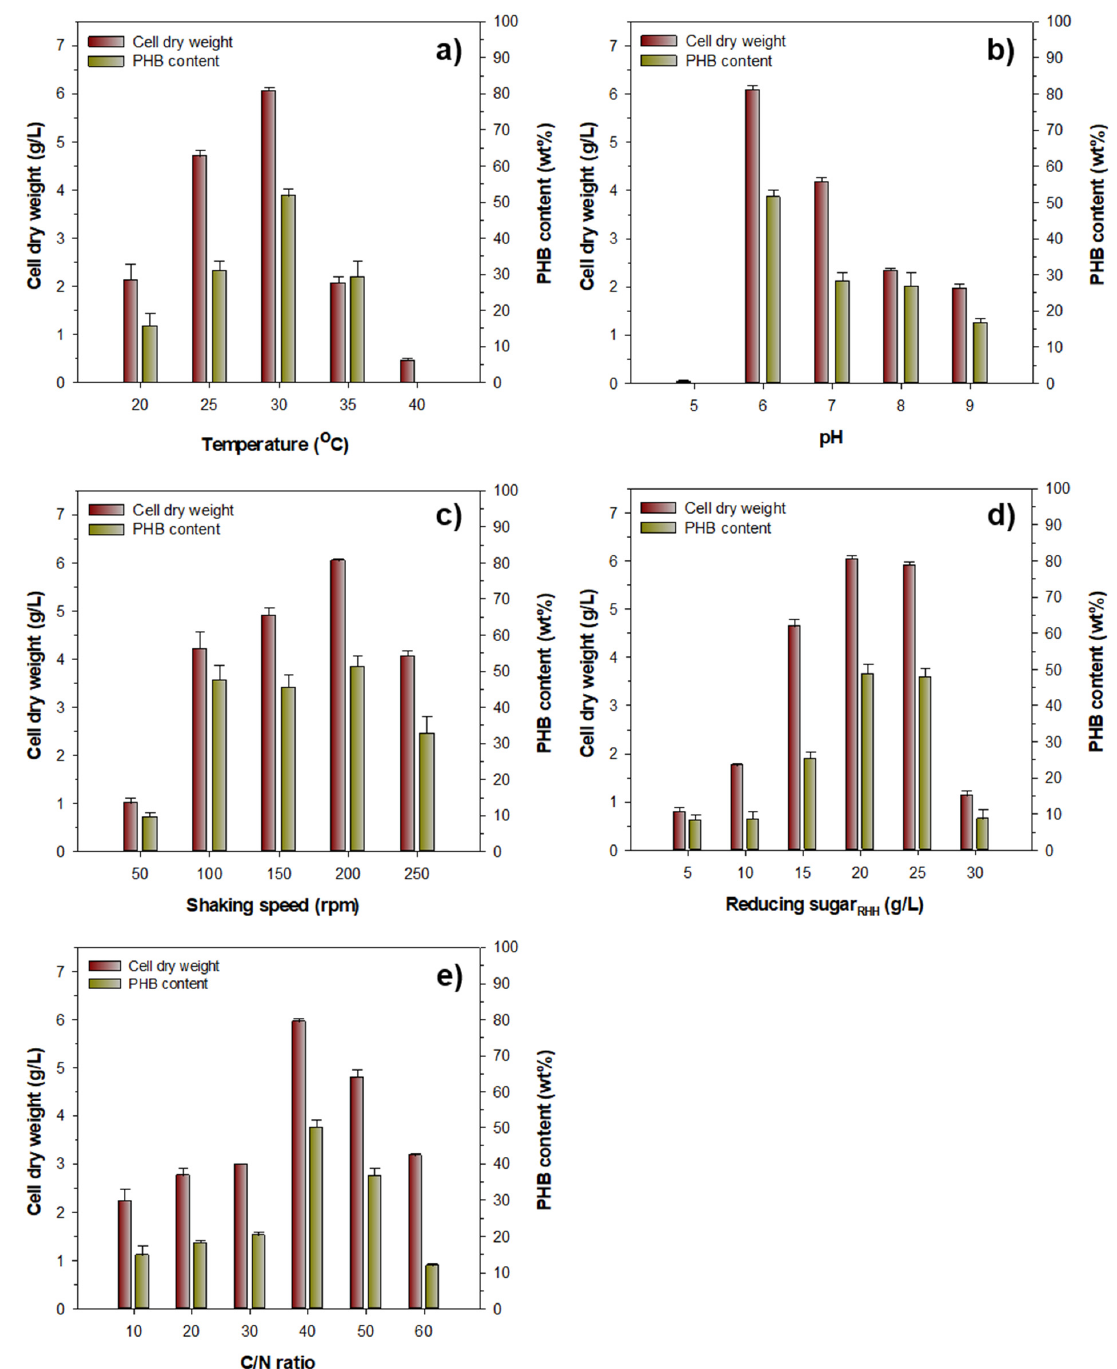
Figure 4. Effect of various culture conditions on the growth and PHB production of Priestia sp. strain JY310. The flask cultures of strain JY310 were performed for 60 h, as described in the Materials and Methods section. The optimal culture temperature ( a ) of the organism was examined at 20, 25, 30, 35, and 40 °C, respectively, and its optimal medium pH was determined in a pH range from 5.0 to 9.0 ( b ). The shaking speed ( c ) to optimize the growth and PHB production of strain JY310 was investigated at 20, 100, 150, 200, and 250 rpm, respectively. The optimal concentration of reducing sugar RHH ( d ) in the culture medium to support its growth and PHB production was evaluated in a concentration range from 5 to 30 g/L. The optimal C/N ratio ( e ) was assessed in the range between 10 and 60. The values are mean ± SD of triplicate tests.